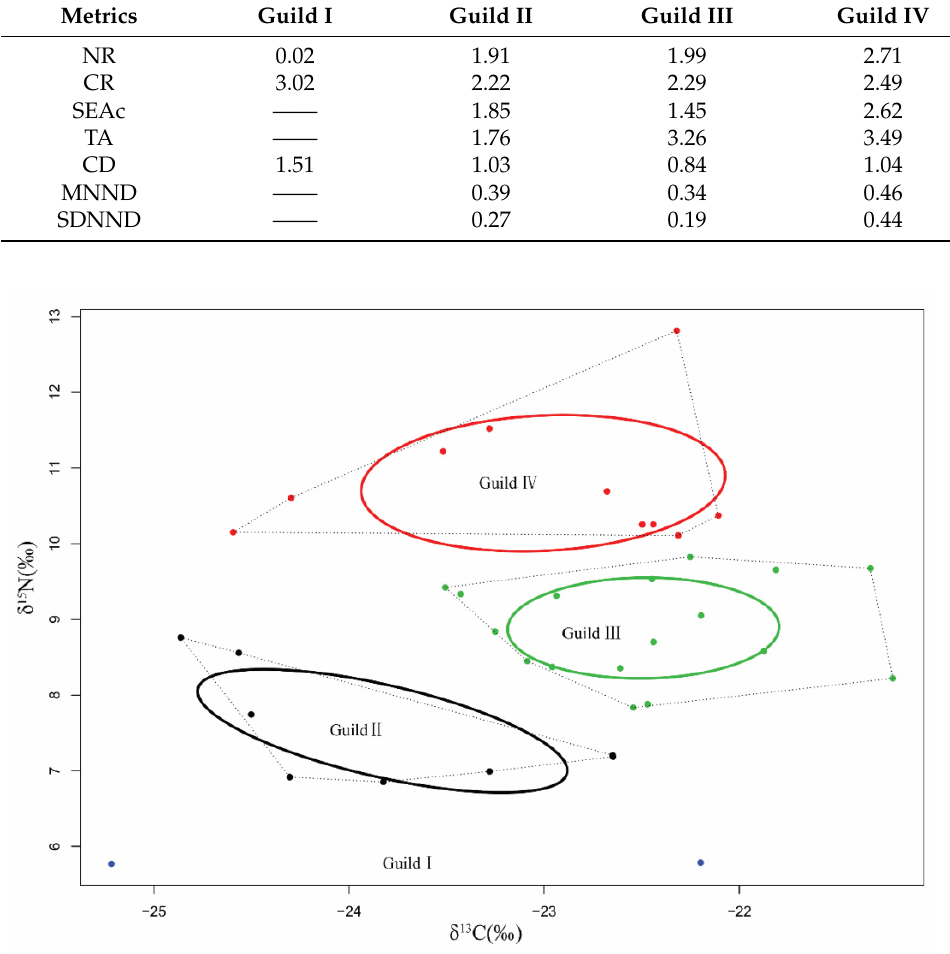
Figure 4. Isotopic niche for trophic guilds of fish in the midstream of the Chishui River. Table 3. Trophic niche metrics for trophic guilds of fish in the midstream of the Chishi River.